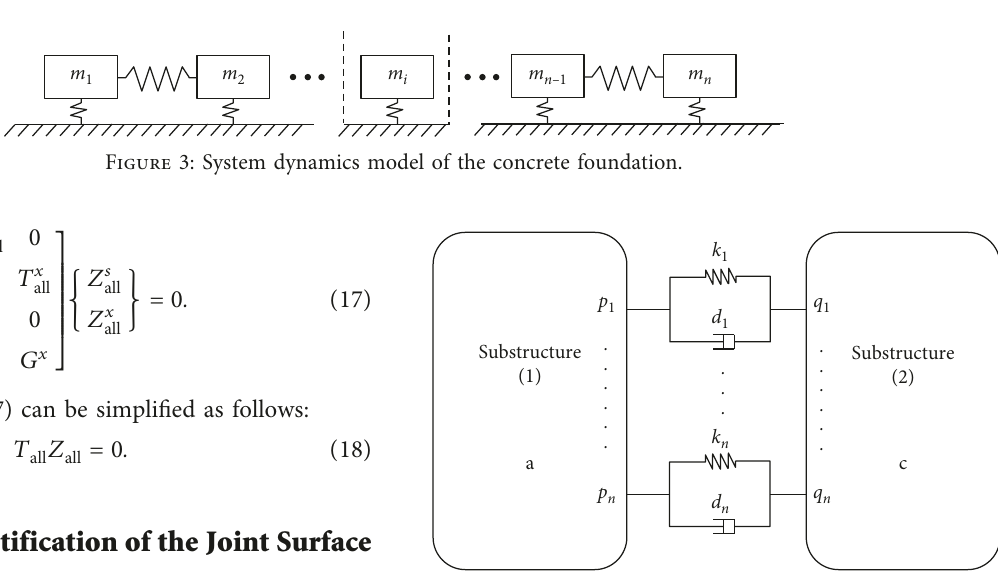
Figure 4: Typical structure of the heavy machine tool consisting of two substructures attached via bolted